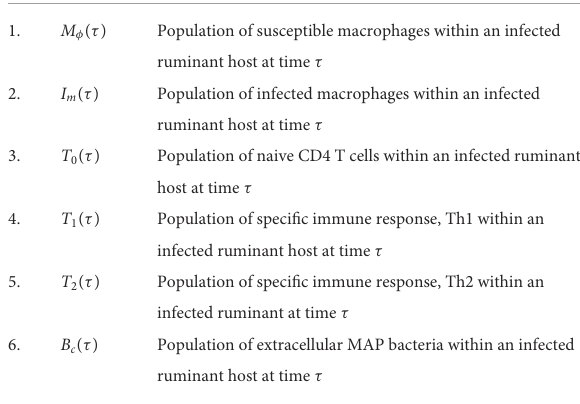
TABLE 2 A summary of the variables associated with the replication cycle of PTB at the within-host